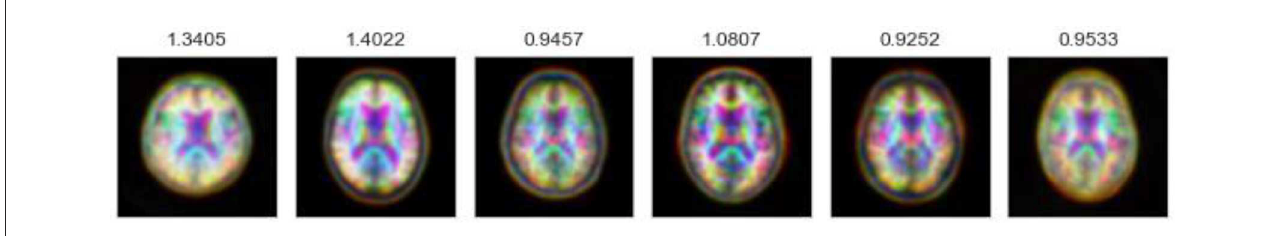
FIGURE1 Color composites of various subjects with ground truth SUVR values.